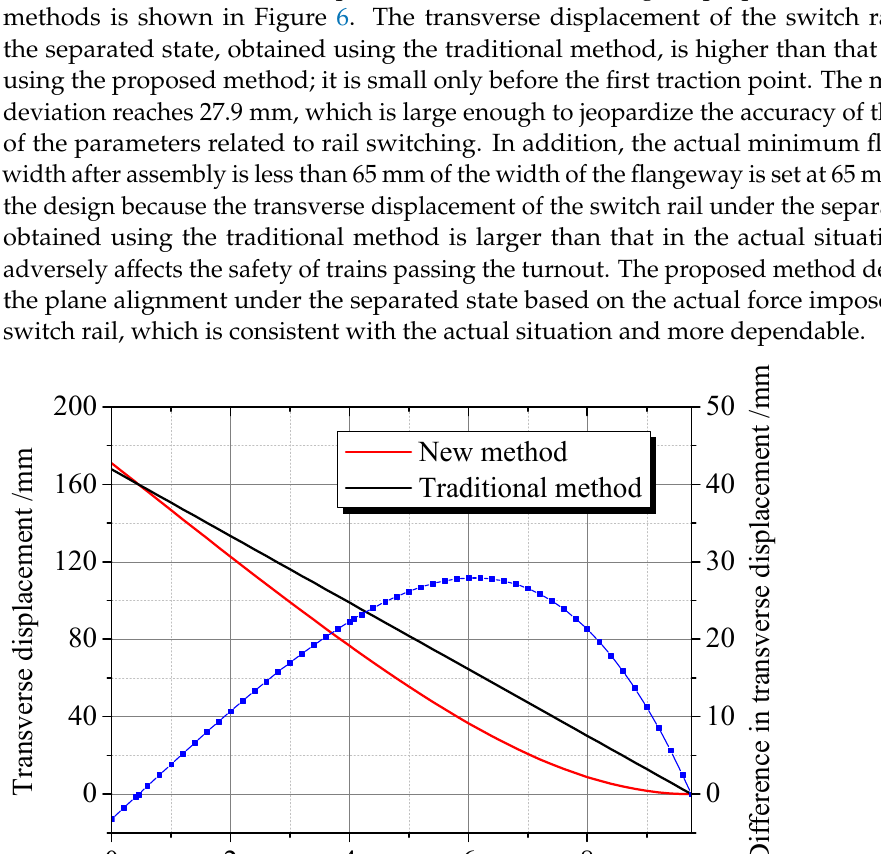
6 of 15 Figure 5. Transverse displacement distribution curve of switch rail separated from stock rail. Based on the design scheme, the plane alignment of the switch rail very close to the stock rail is obtained. The same discretization method is employed on the switch rail to obtain the longitudinal position coordinates of